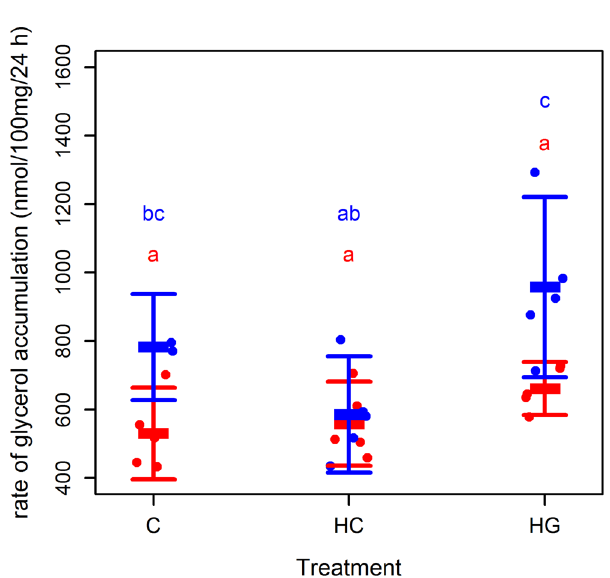
Figure 3. Effect of glucose and hydrocortisone on glycerol accumulation in media from grey seal blubber explants. Glycerol accumulation ( Δ glycerol 24 h − 1 100 mg − 1 ) by 100 mg blubber tissue explants from grey seals (n = 10). Each point represents one animal (red = female; blue = male). Bars represent mean ( ± s.d.). Tissues were minced and incubated in DMEM with 10% fetal bovine serum 5% penicillin and streptomycin, and glutamine. Explants from the same animal were supplemented with 5.5 mM glucose (C), 25 mM glucose (HG) or 5.5 mM glucose + 500 nM hydrocortisone (HC). Media was harvested after overnight (24 h) incubation. Different letters indicate where treatments were significantly different from each other (LME: p <